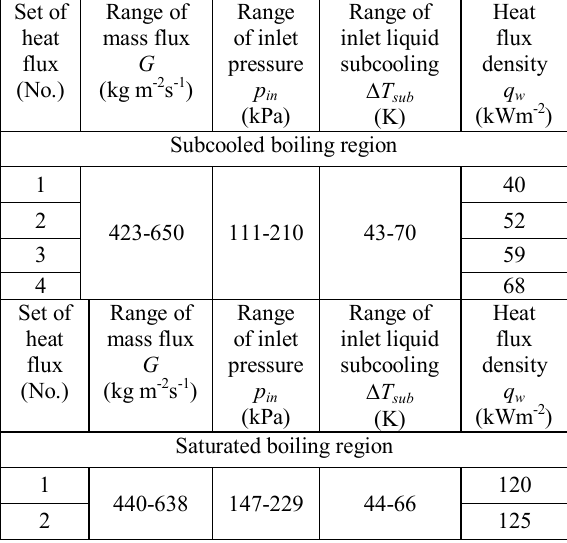
Table 2 The basic thermal and flow properties of and